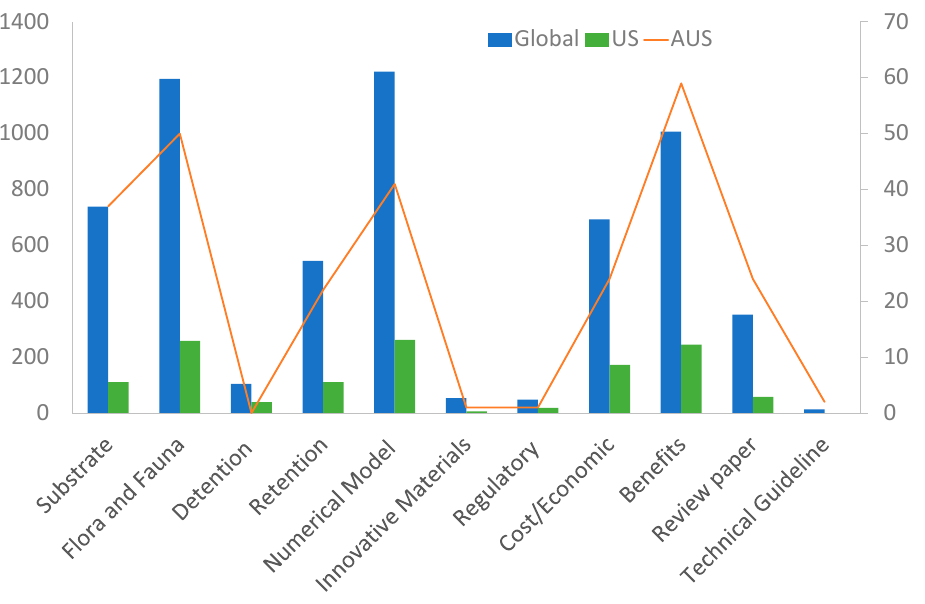
Figure 7. Research Trend